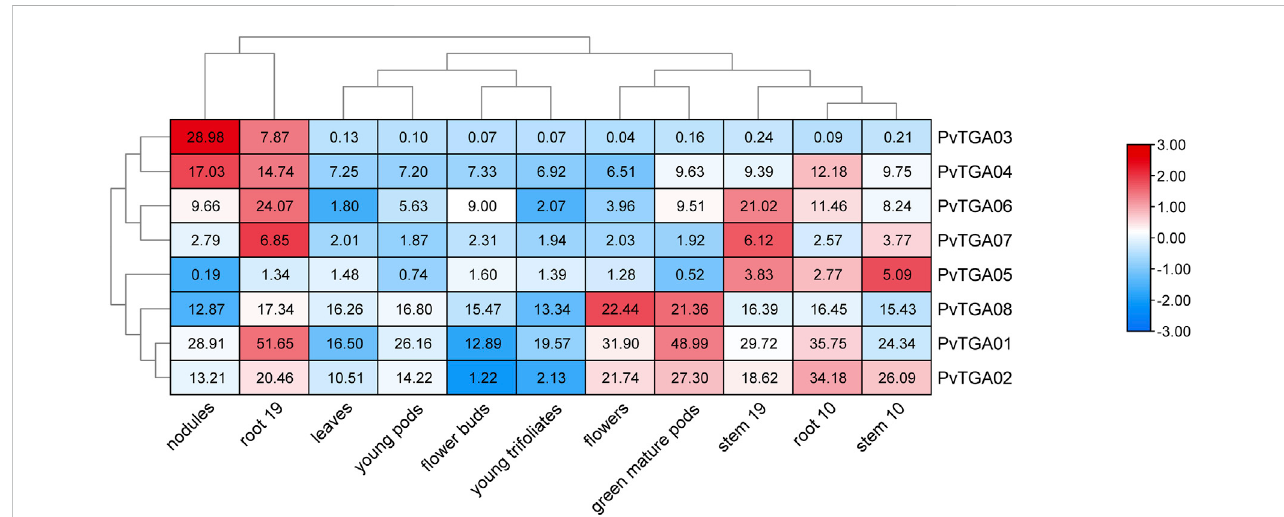
FIGURE 6 Expression pro fi les of PvTGA genes from common bean in 11 different tissues. Heat-map clustering based on FPKM expression of 8 PvTGA genes in different common bean tissues. Log2-transformed values are used in a color-coded heatmap, with bars representing gene-normalized FPKM (Log2) expression levels, and red for higher expression, blue means low.